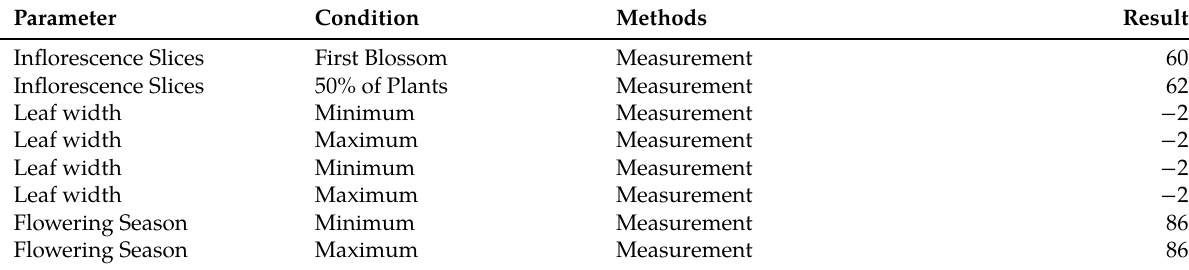
Table 1: Example of ambiguous attribute values in column “ Condition ”